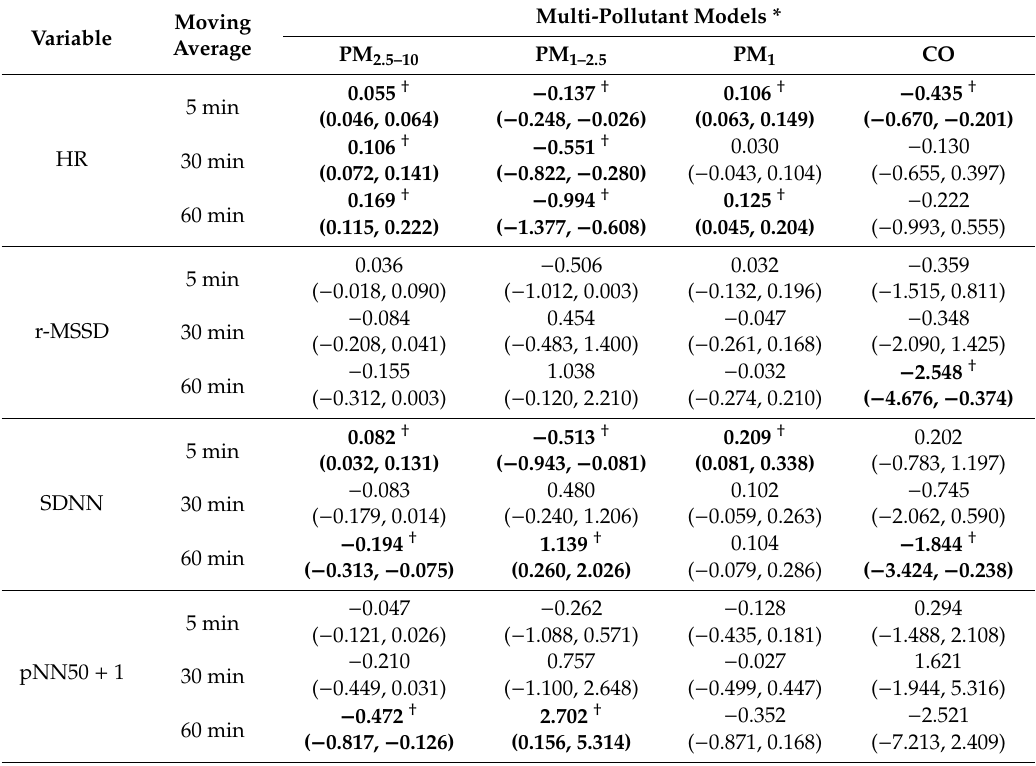
Table 3. Short-term exposure impacts on time domain HRV indices in multi-pollutant models.